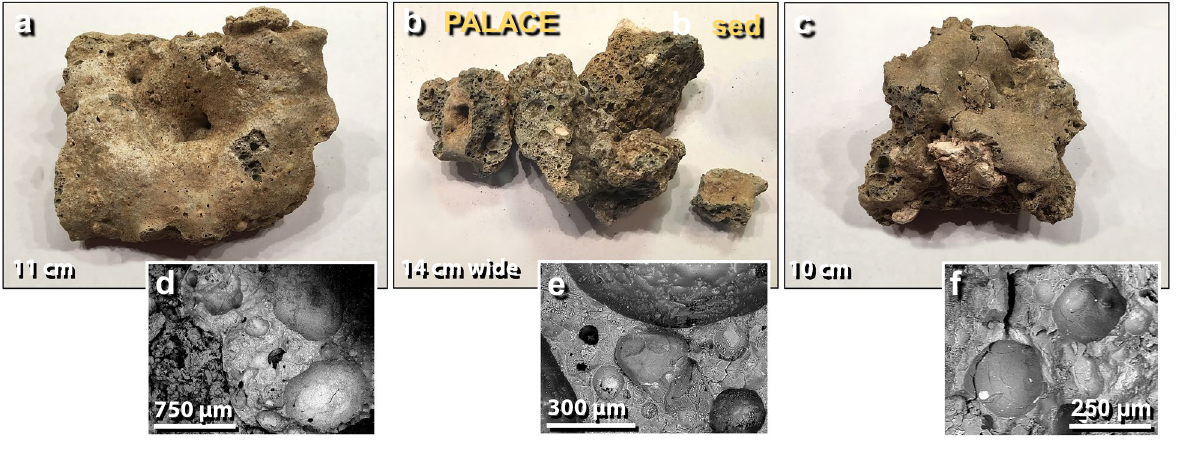
Figure 11. Melted mudbrick from the palace. ( a ) The upper surface of meltglass, showing non-vesicular ‘skin’; ( b ) broken surfaces of meltglass displaying vesicular texture; ( c ) upper surface and broken faces of meltglass. Note large unmelted light-colored mineral inclusion. ( d )–( f ) SEM images of highly vesicular surfaces of broken meltglass. Note bright metallic inclusions in several